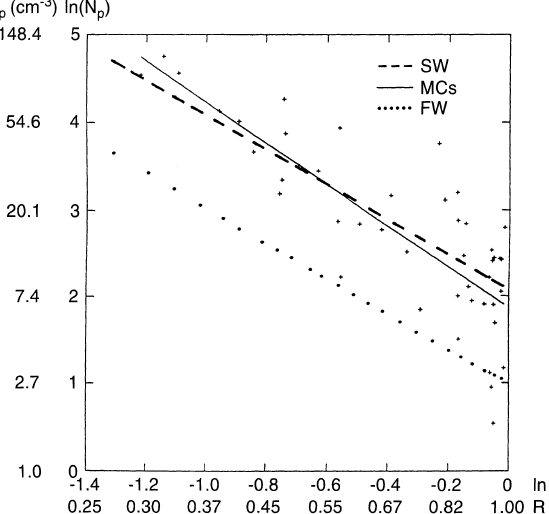
Fig. 15. Double logarithmic plot showing the average proton density inside MCs observed by Helios 1/2 between 0.3 and 1 AU during 1974–1981. The straight line was obtained by linear regression: N p (cid:133) R (cid:134) (cid:136) (cid:133) 6 : 47 (cid:6) 0 : 85 (cid:134) (cid:2) R (cid:255) 2 : 4 (cid:6) 0 : 3 cm (cid:255) 3 ( R in AU). Dashed and dotted lines represent slopes for proton densities measured by the Helios probes in slow (S) and fast (F) solar wind-streams in the inner heliosphere (taken from